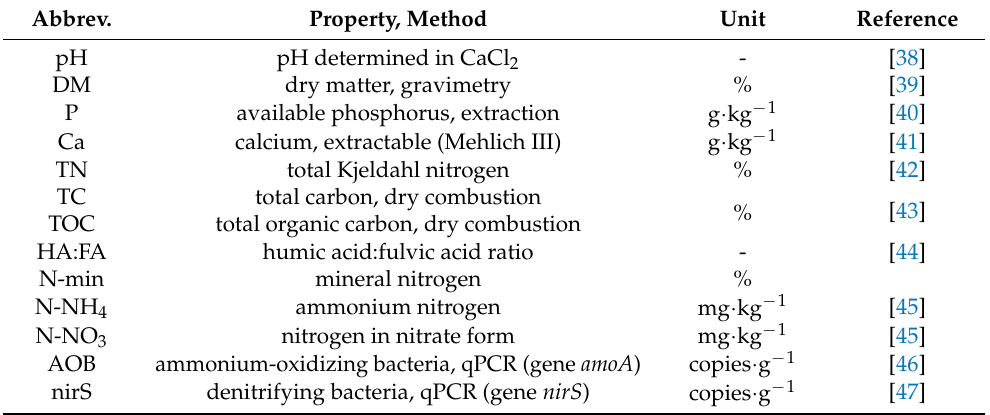
Table 2. Determined manure properties, methods used for measurement, relevant references.